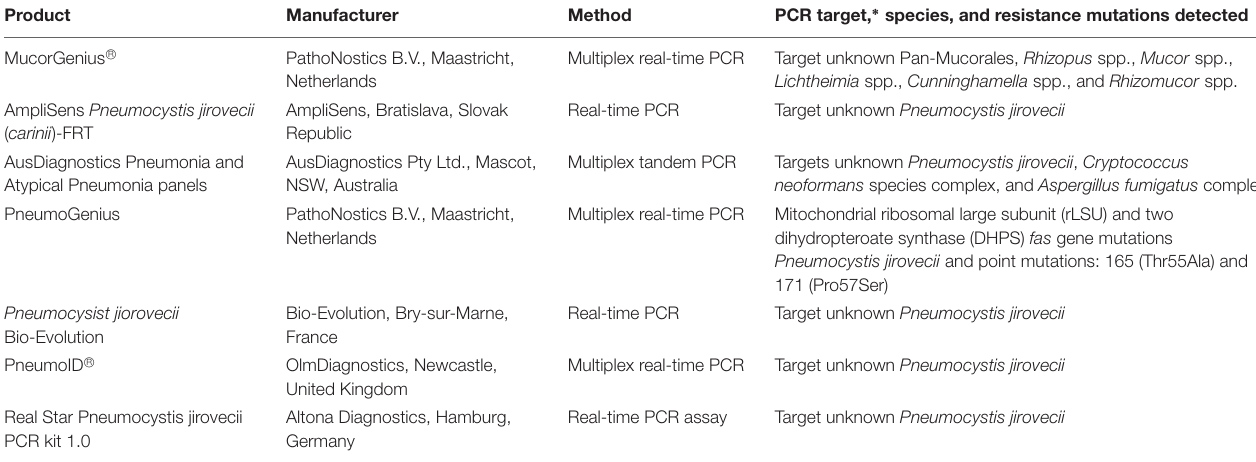
TABLE 3 | List of commercially available PCR-based assays for detection of Mucorales and Pneumocystis jirovecii . Product